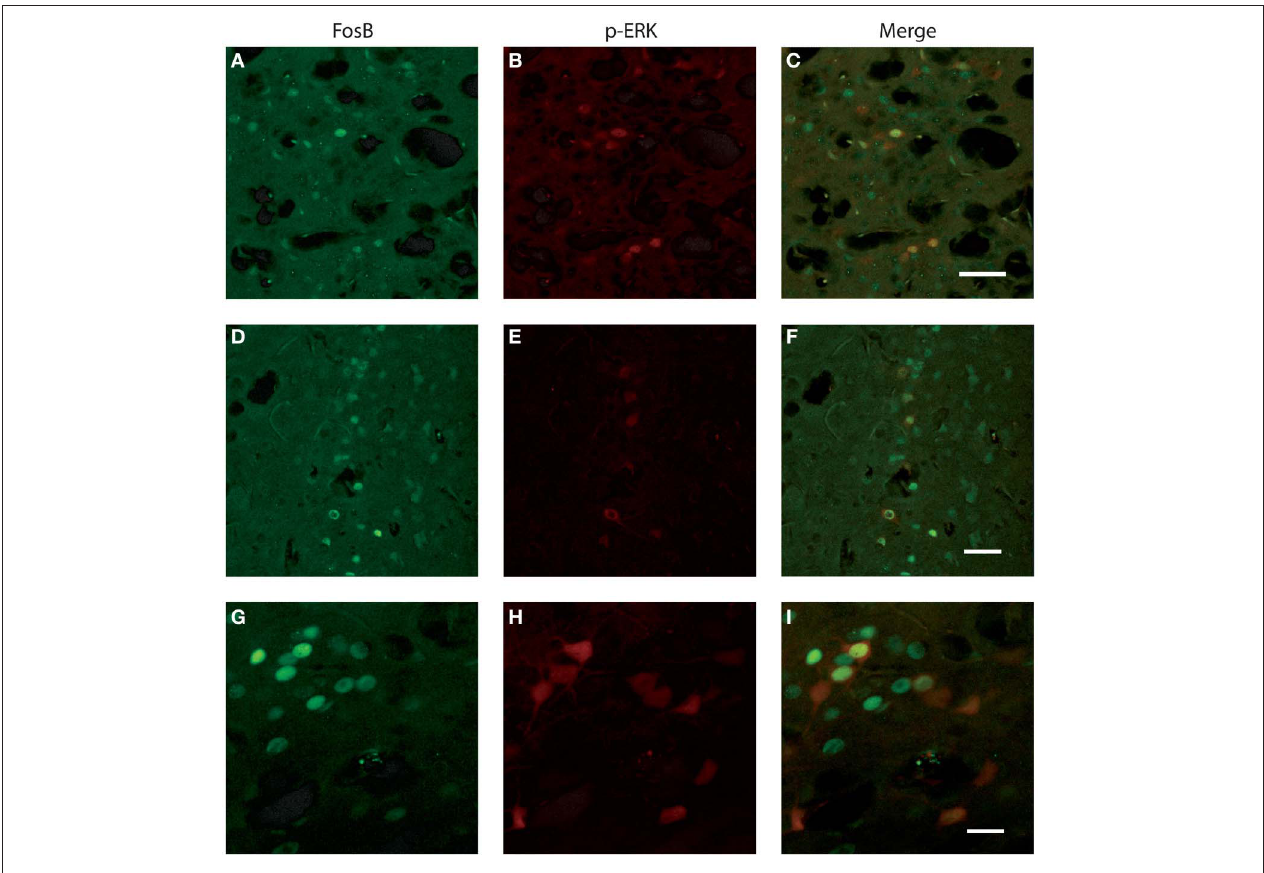
FIGURE 6 | Photomicrographs illustrating double immunofluorescence experiments with antibodies against p-ERK1/2 and FosB/ (cid:2) FosB in three exampled mice. (A–C) illustrate the co-labeling of subicular neurons in a Fmr1 KO mouse at P45. (D–F) demonstrate the